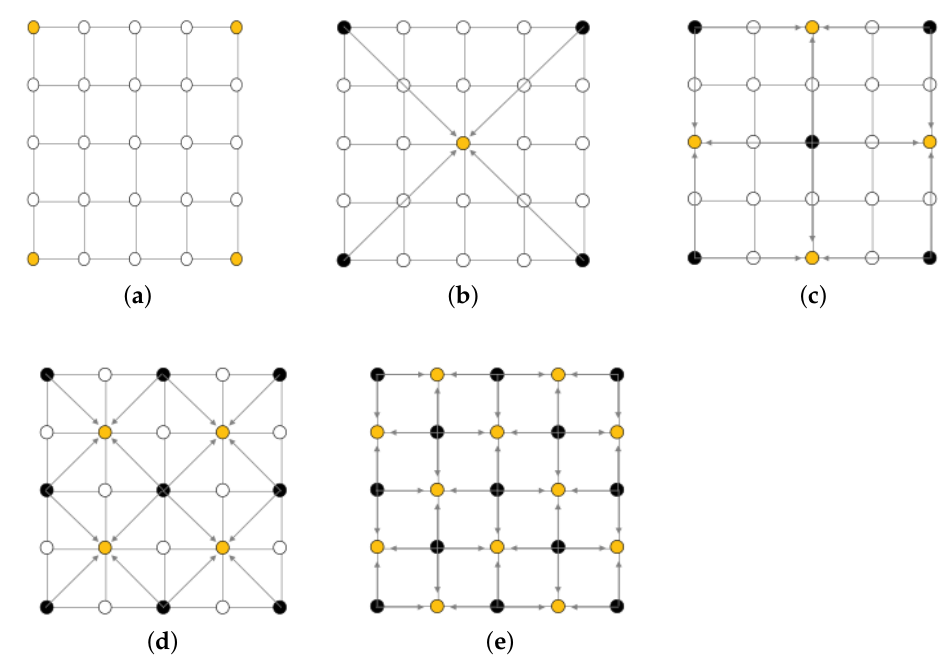
Figure 12. Diamond square algorithm on a 5 × 5 array: ( a ) Initialize corner grid values, ( b ) execute diamond step, ( c ) execute square step, ( d ) execute diamond step, ( e ) execute square step. (Image